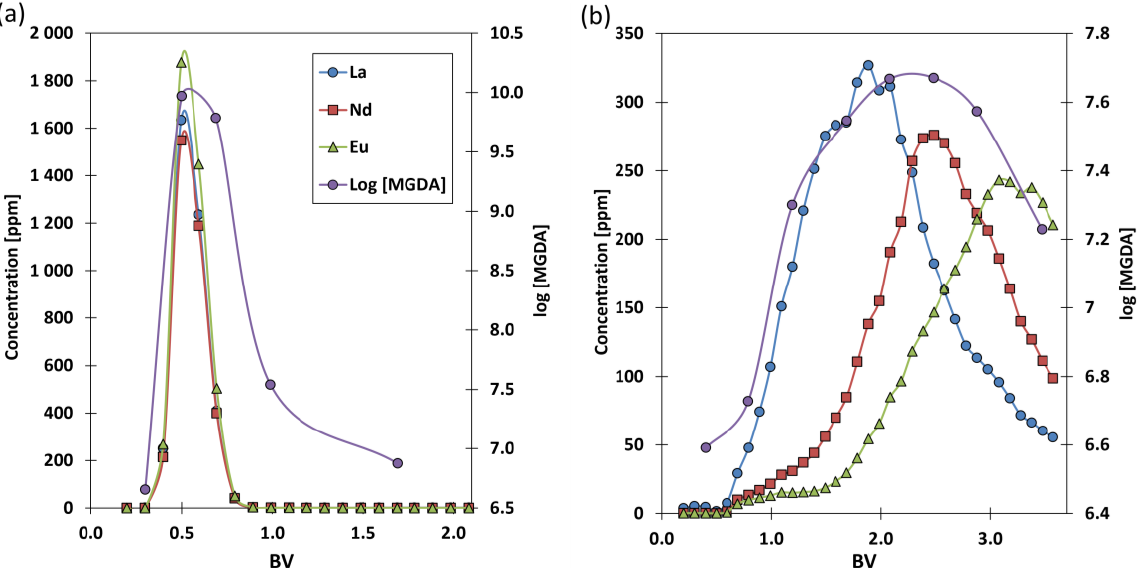
Figure 11. Chromatograms of the two-step process with separate loading and elution steps. In addition to [REE], the logarithmic [MGDA] is shown (T = 298 K ± 2 K; flowrate = 2.98 BV/h; feed (#2) = 0.1 BV; eluent = ( a ) deionized water, ( b ) 0.01 M HCl).